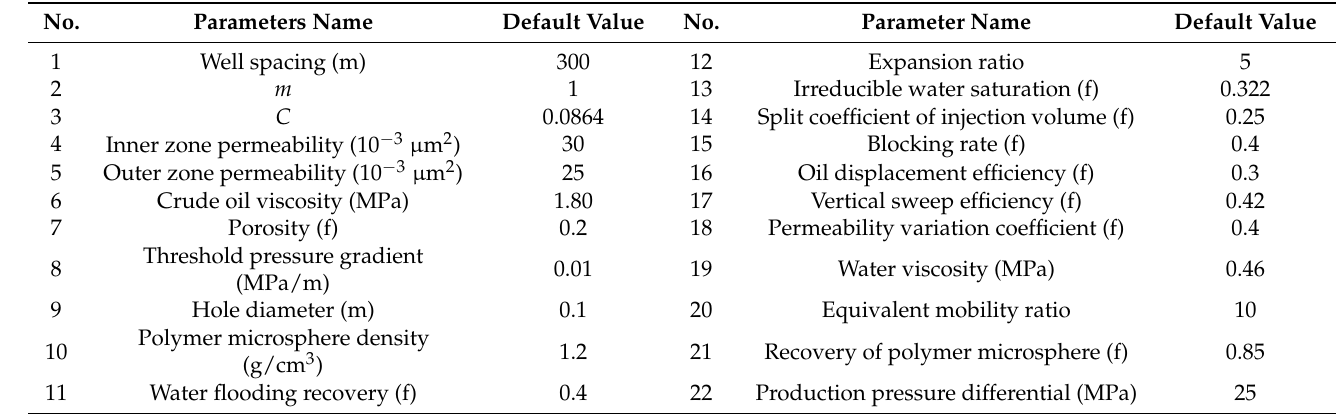
Table 2. Support parameters for sensitivity analysis.